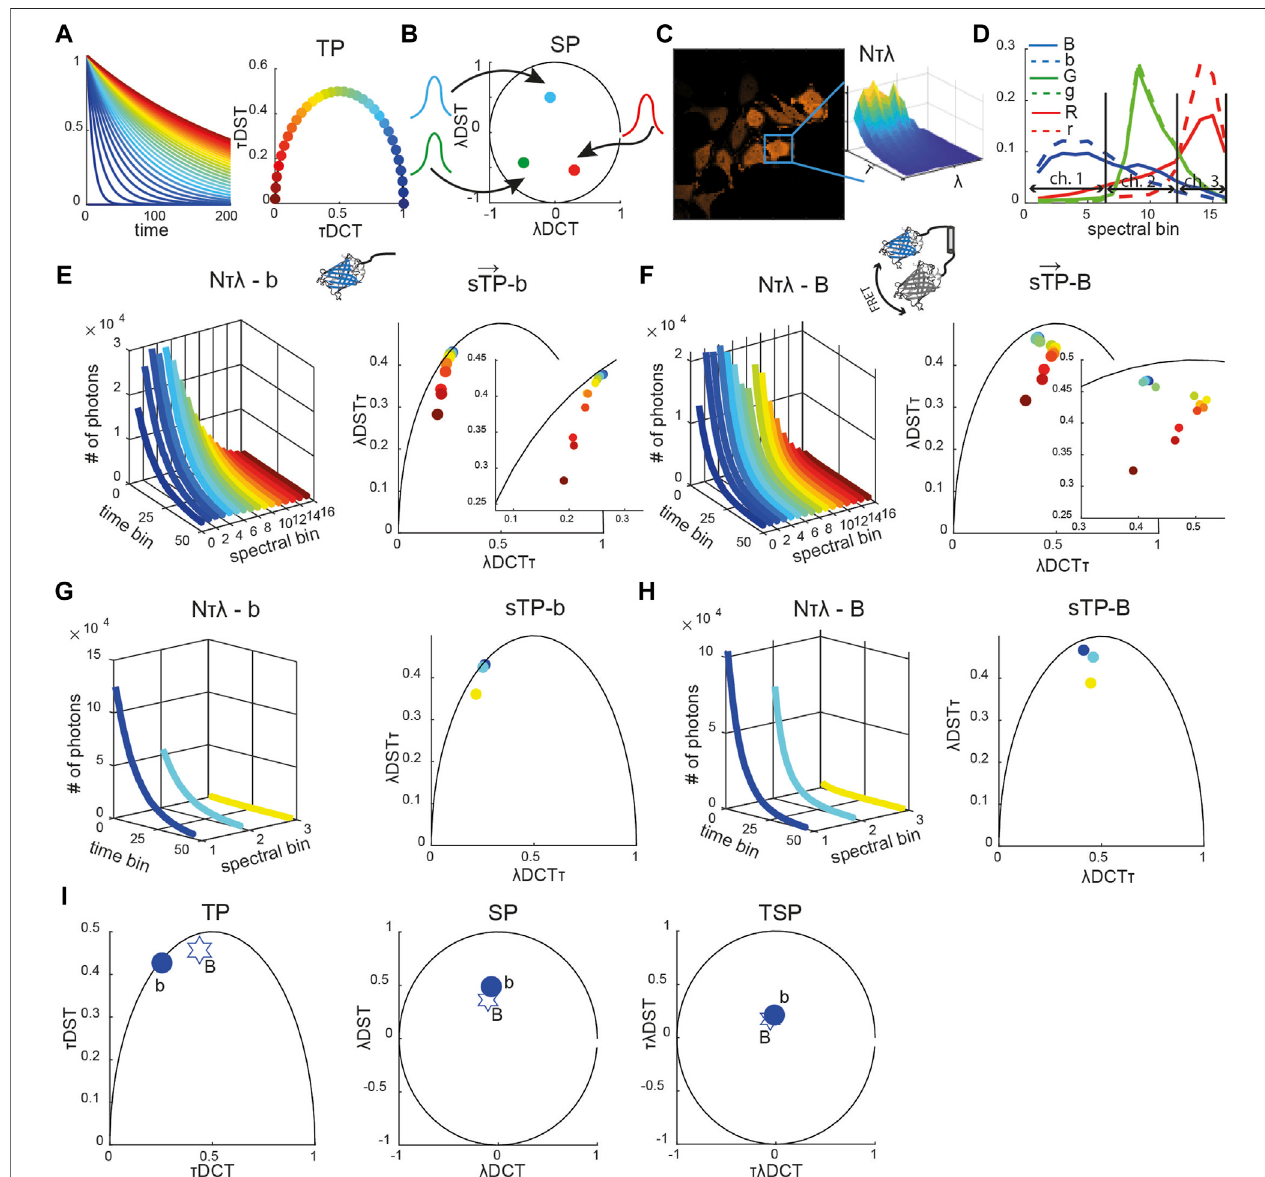
FIGURE 1 | Reference spectrally resolved fi ngerprint. (A) Diagrammatic representation of exponential decay curves ( τ from ∼ 0 ns in blue to 240 ns in crimson) shown in the time-domain (left) and time phasor space (circles, right panel). (B) Diagrammatic representation of Gaussian spectra (colored curves) and their representation as spectral phasors (solid circles). (C) Representative image of HeLa cells expressing a blue caspase-2 sensor (see Supplemetary Figure S1 for green and red sensors) with the spectrally resolved time decay N ( τ , λ ) integrated over the mask of a single segmented cell is shown (inset). (D) Spectra of the blue (blue solidline),green(greensolidline),andred(redsolidline)positivecontrols(fusionconstructs)andofthecorrespondingnegativecontrols(onlydonors,dashedlines).Each curve was normalized to the total number of counts. The horizontal arrows indicate which spectral bins were used to emulate three-channel (ch.) multicolor FLIM (cid:1)(cid:1)(cid:1) → (mcFLIM) data. Spectrally resolved time-decay N ( τ , λ ) (left panels in (E – H) ) and corresponding spectrally resolved phasors ( sTP , right panel in (E – H) ) for the blue donor (E,G) and positive control (F,H) for sFLIM (E,F) and emulated three-channel mcFLIM (G,H) . Inserts are magni fi cations of the same graphs. (I) The same data from the blue positive (stars markers and label B ) and negative (round marker and label b ) controls are shown transformed also as time-(TP), spectral-(SP), and time-spectral- phasor (TSP) space. Note, fi gure (I) is the same for spectrally resolved FLIM (sFLIM) and mcFLIM. In all panels, DCT-discrete cosine transform, DST-discrete sine transform; λ -marks spectral domain or spectral transformation ( λ DCT/ λ DST); τ -marks time-domain or time phasor transformation ( τ DCT/ τ DST). intervals in LabTek II glass-bottom chambered slides (Nunc, components was performed just before the time-lapse #1.5) containing a 400 µl Leibovitz (L-15) medium experiment, with HeLa-CCL2 cells transiently transfected supplemented with 10% FCS, 100 μ M Cisplatin, and 0.9% with donor fl uorophores not fused with an acceptor, and a donor – acceptor fusion pair (known FRET), as shown in [27].